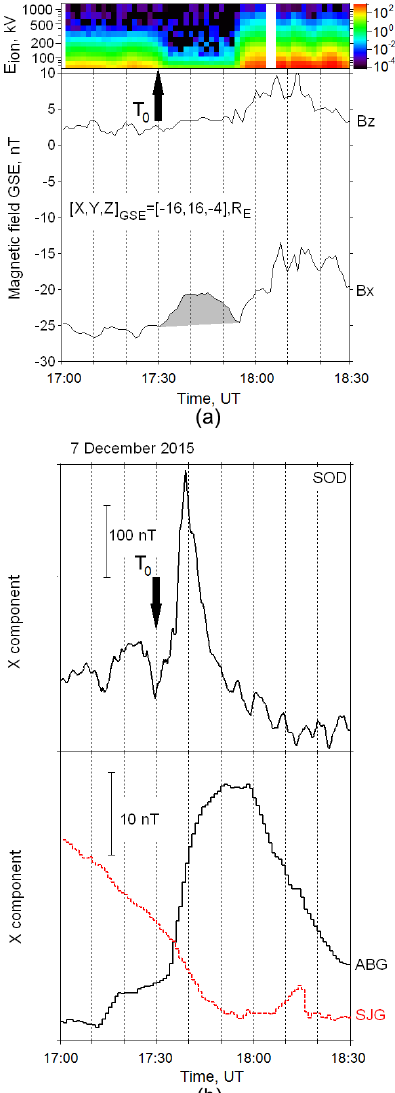
Figure 8. (a) Spectrogram showing the intensity variations of the differential ion flux (top panel) and magnetic field at GEOTAIL (bottom panel). (b) Variations of the geomagnetic X component at subauroral (SOD) and low-latitude (Alibag – ABG; San Juan – SJG) stations. The black arrow indicates the polar substorm onset time, T 0 , and the dayside variation is indicated in